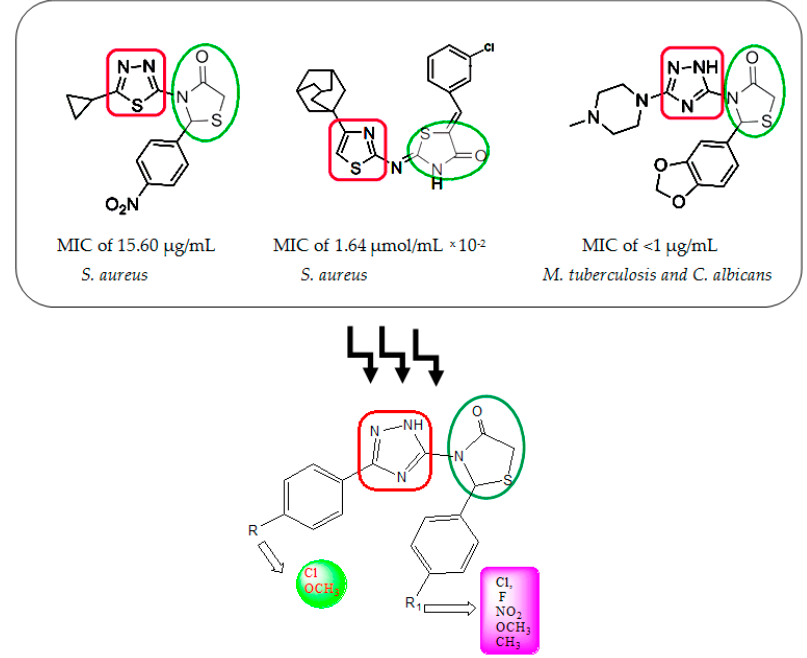
Figure 2. Rationale and design of title Compounds 7c – l based on the thiazolidin-4-one and the triazole scaffold.